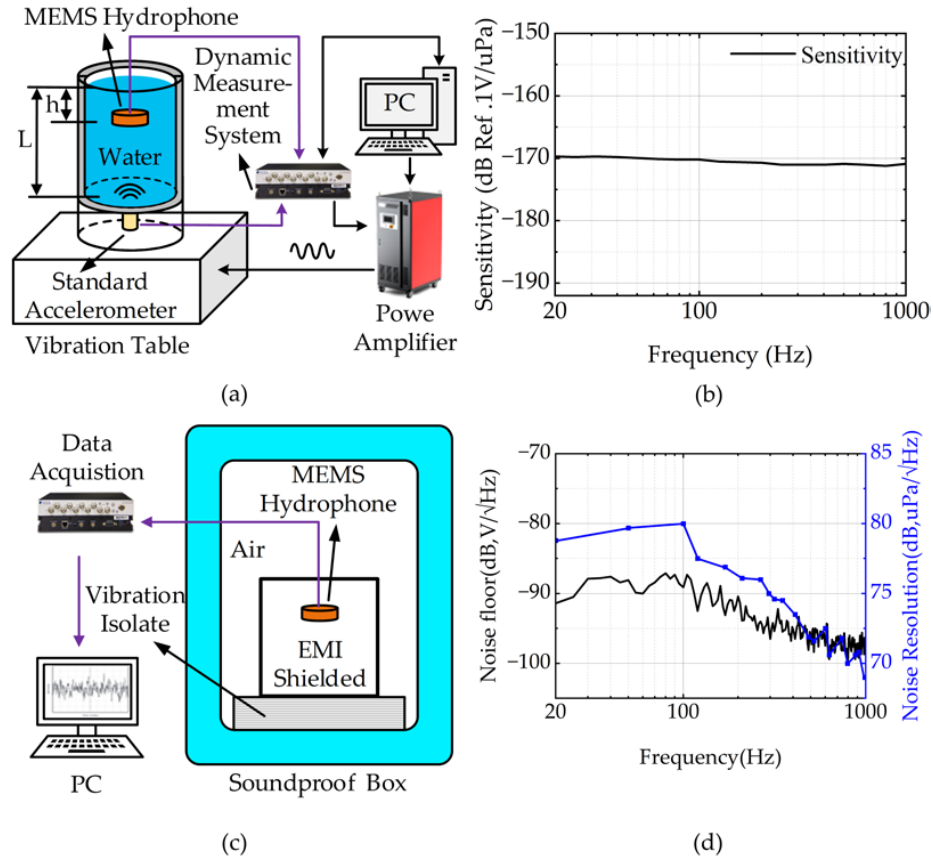
Figure 5. MEMS Hydrophone characterization and results: ( a ) vibrating liquid column calibration setup, ( b ) the receiving sensitivity of the MEMS hydrophone, ( c ) schematic diagram of the noise calibration device, ( d ) the noise density and noise resolution of the MEMS hydrophone.